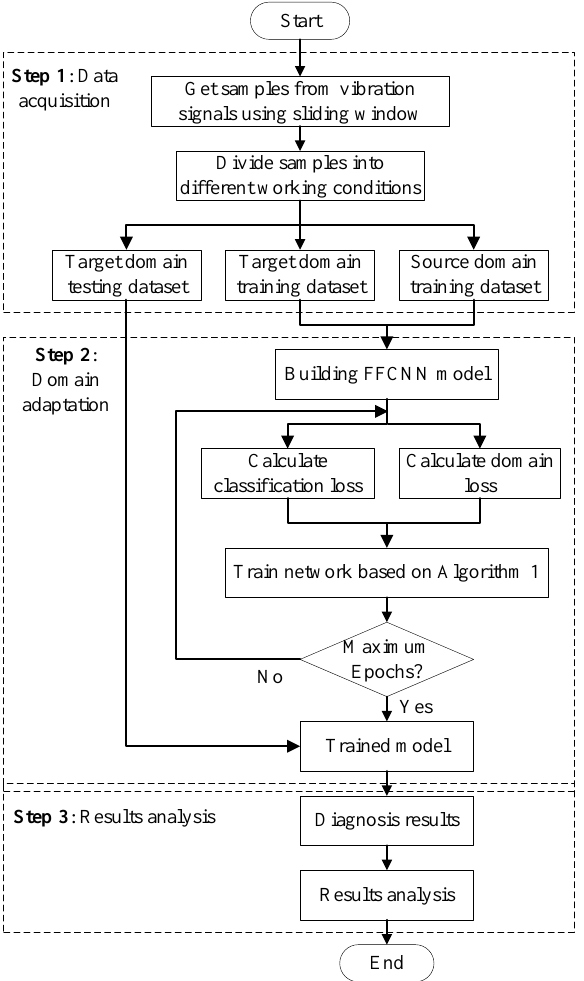
Figure 5. Flowchart of proposed FFCNN for fault diagnosis.